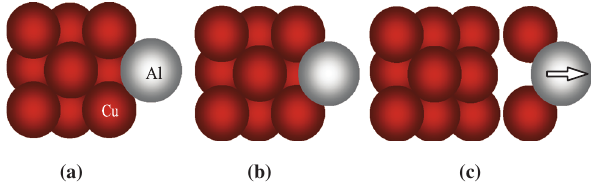
Figure 8: Dissolved process of Cu atoms in Al liquid (a) Liquid Al atom contacting with solid Cu atoms (b) Accomplishing the reconfiguration of extra-nuclear electrons (c) Cu atoms entering into Al liquid with Al